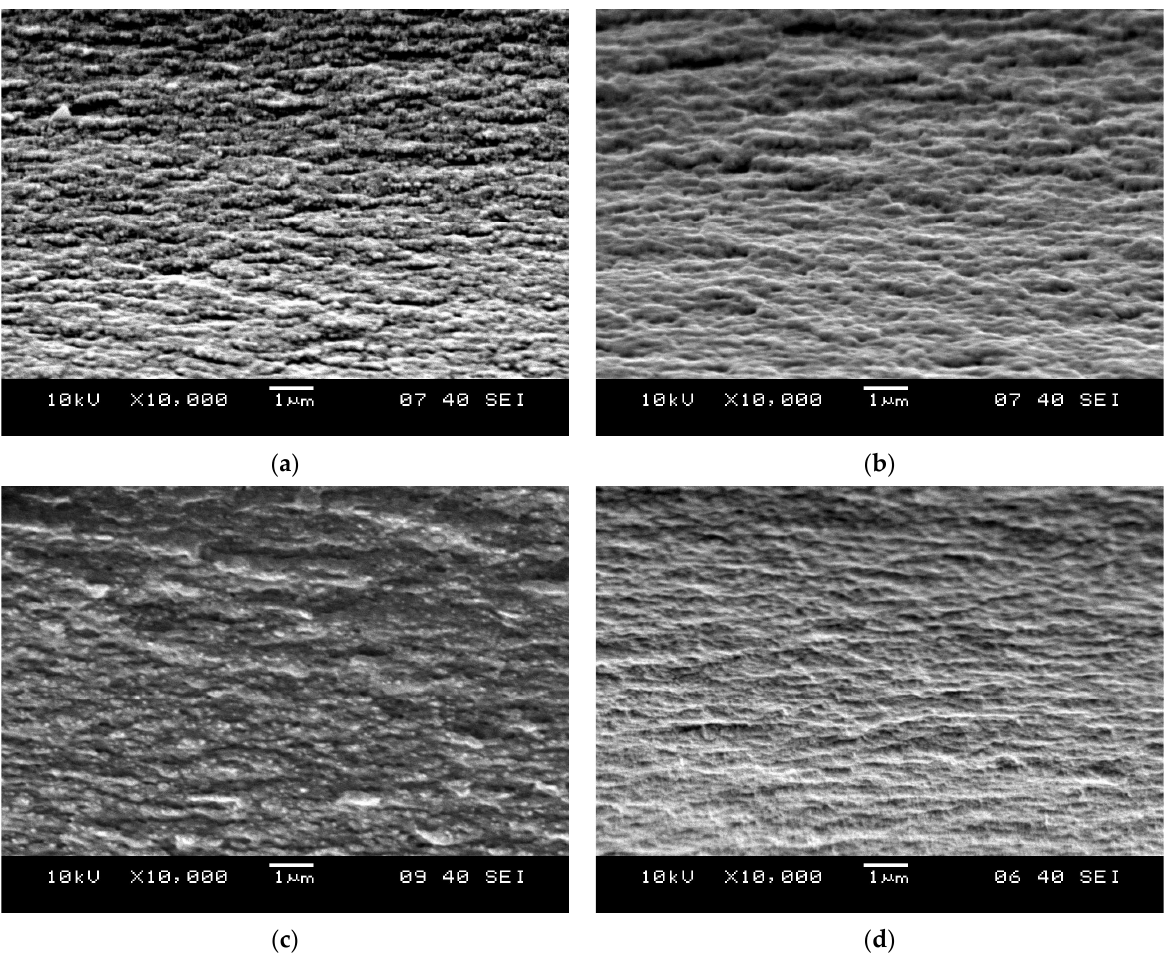
Figure 2. SEM images of cryogenic fracture surfaces of CNC fi lms plasticized with 15% glycerol; ( a ) neat; ( b ) neat after heating at 160 °C for 10 min; ( c ) CA-30% fi lm; ( d ) CA-30% fi lm after heating at ( a ) neat; ( b ) neat after heating at 160 ◦ C for 10 min; ( c ) CA-30% film; ( d ) CA-30% film after heating at 160 °C for 10 min (M: 10,000×). 160 ◦ C for 10 min (M: 10,000 ×